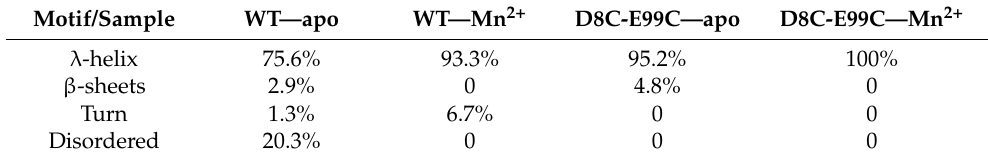
Figure 8. CD spectra in SEC buffer of 40 µM Bacillus subtilis apo-MntR in SEC buffer (blue trace) and upon addition of 80 µM of Mn(Ac) 2 (red trace); and Bacillus subtilis apo-MntR D8C-E99C mutant (green trace) and the same sample after addition of 80 µM of Mn(Ac) 2 (purple trace). Table 2. The percentages of particular secondary structure motifs, as calculated using the Bestsel algorithm.